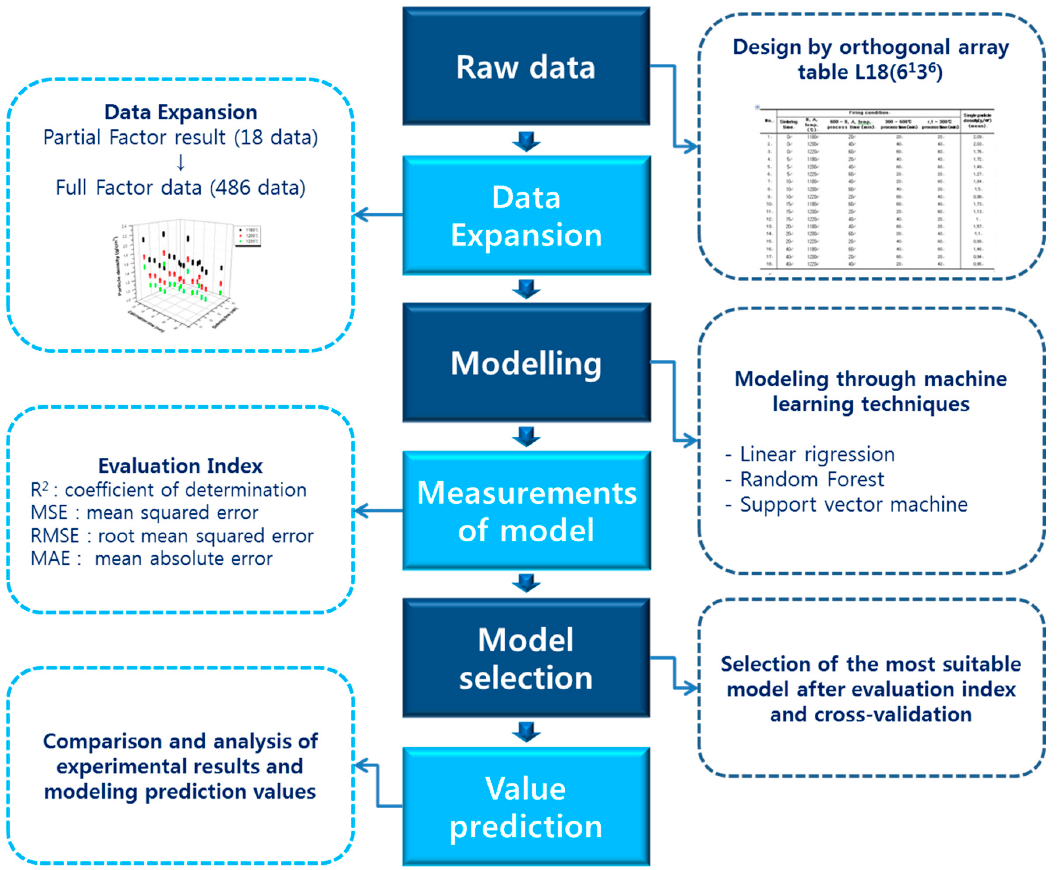
Figure 1. Flow chart for data expansion and machine-learning analysis.